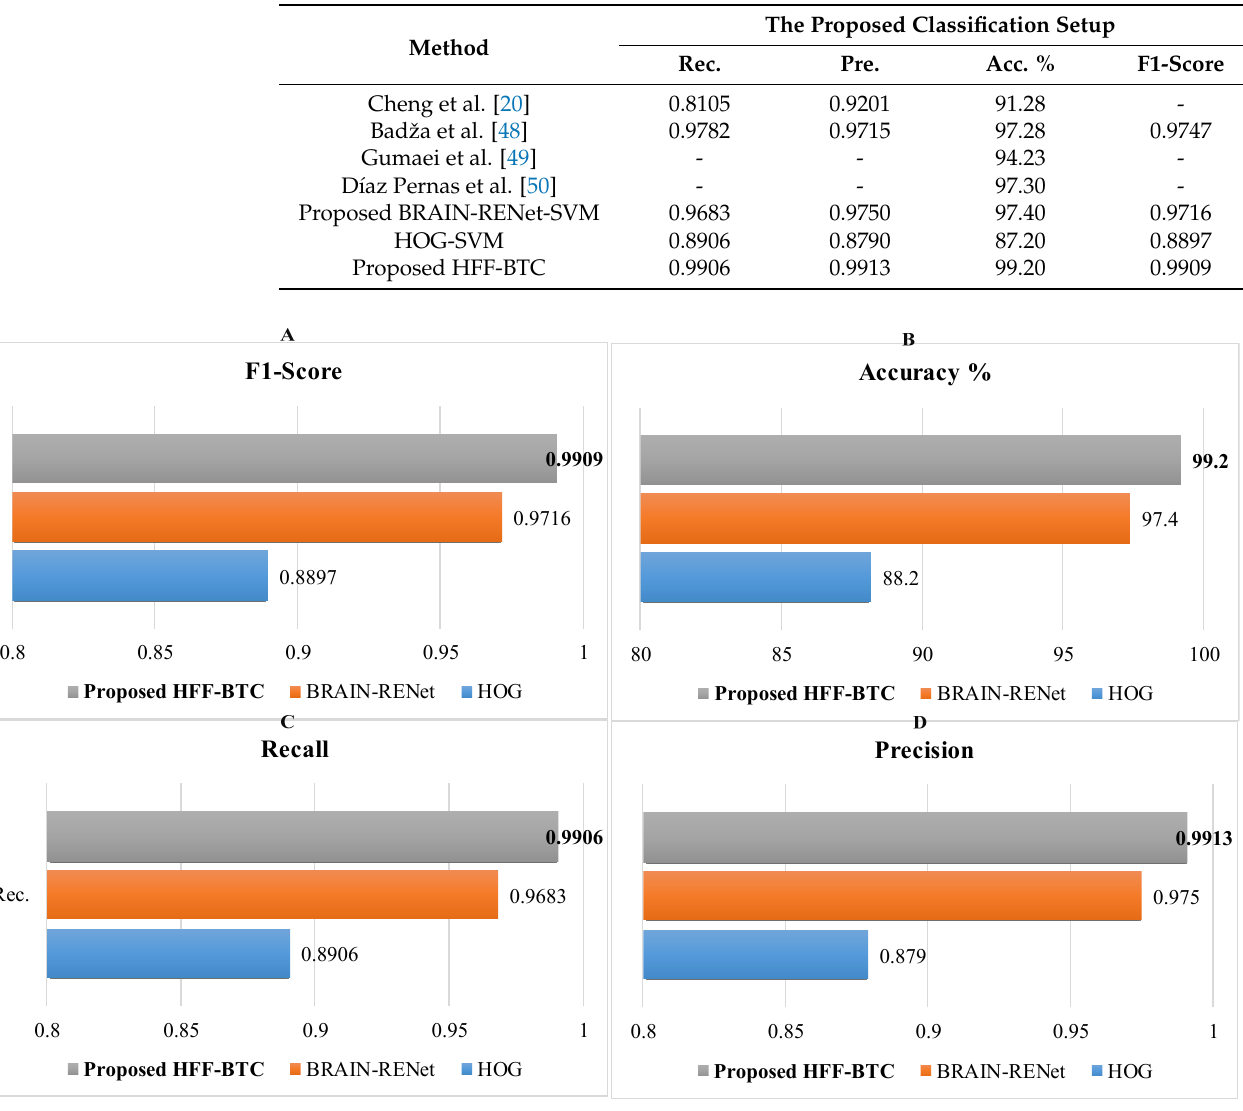
Figure 8. Performance comparison of HFF-BTC models in terms of (A) F1-score, (B) accuracy, (C) recall, and (D) precision.